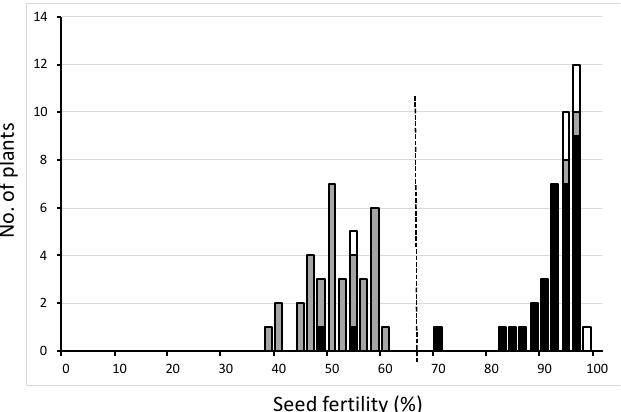
Figure 2. Frequency distribution of seed fertility of one BC 5 F 4 population using T65 as the recurrent